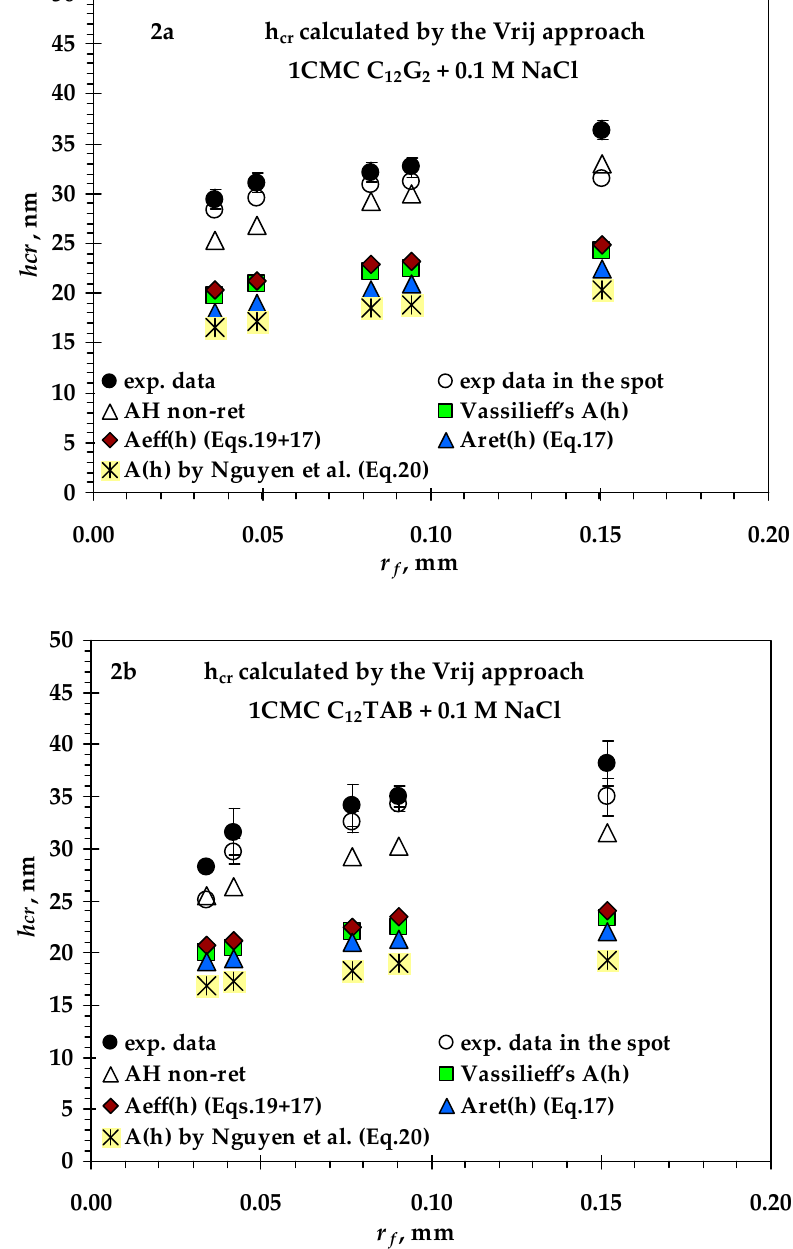
Figure 2. Measured and calculated critical thickness ( h cr ) by Frij approach with di ff erent values of A(h), for foam films from solutions with ( a ) n -dodecyl- β -D-maltoside (C 12 G 2 ) or ( b ) cationic surfactant n-dodecyl trimethylammonium bromide (C 12 TAB) at 1.0 C М C, in the presence of 0.1 М